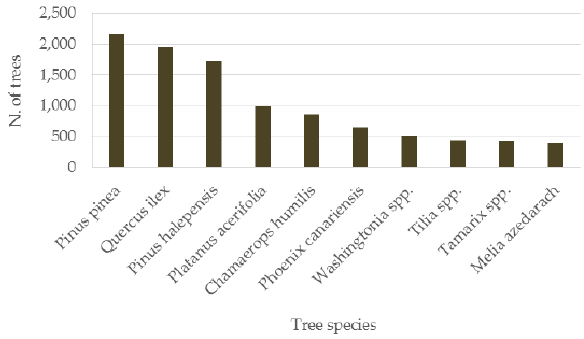
Figure 1. Main ornamental tree species in the City of Bari. Source: Urban Forestry Department—City of Bari, 2014 (Our data processing).